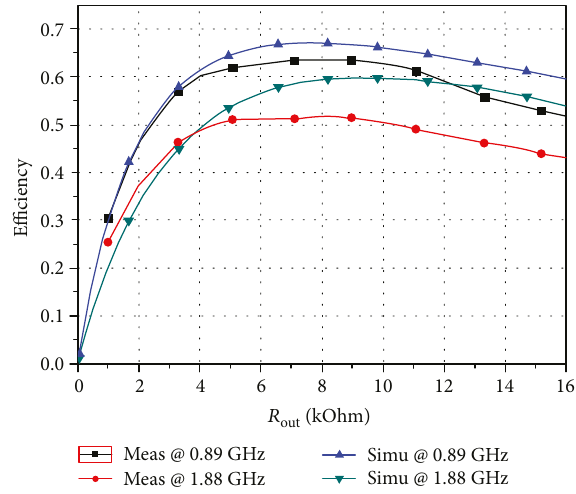
Figure 10: Simulated and measured re fl ection coe ffi cient of the dual band recti fi er.